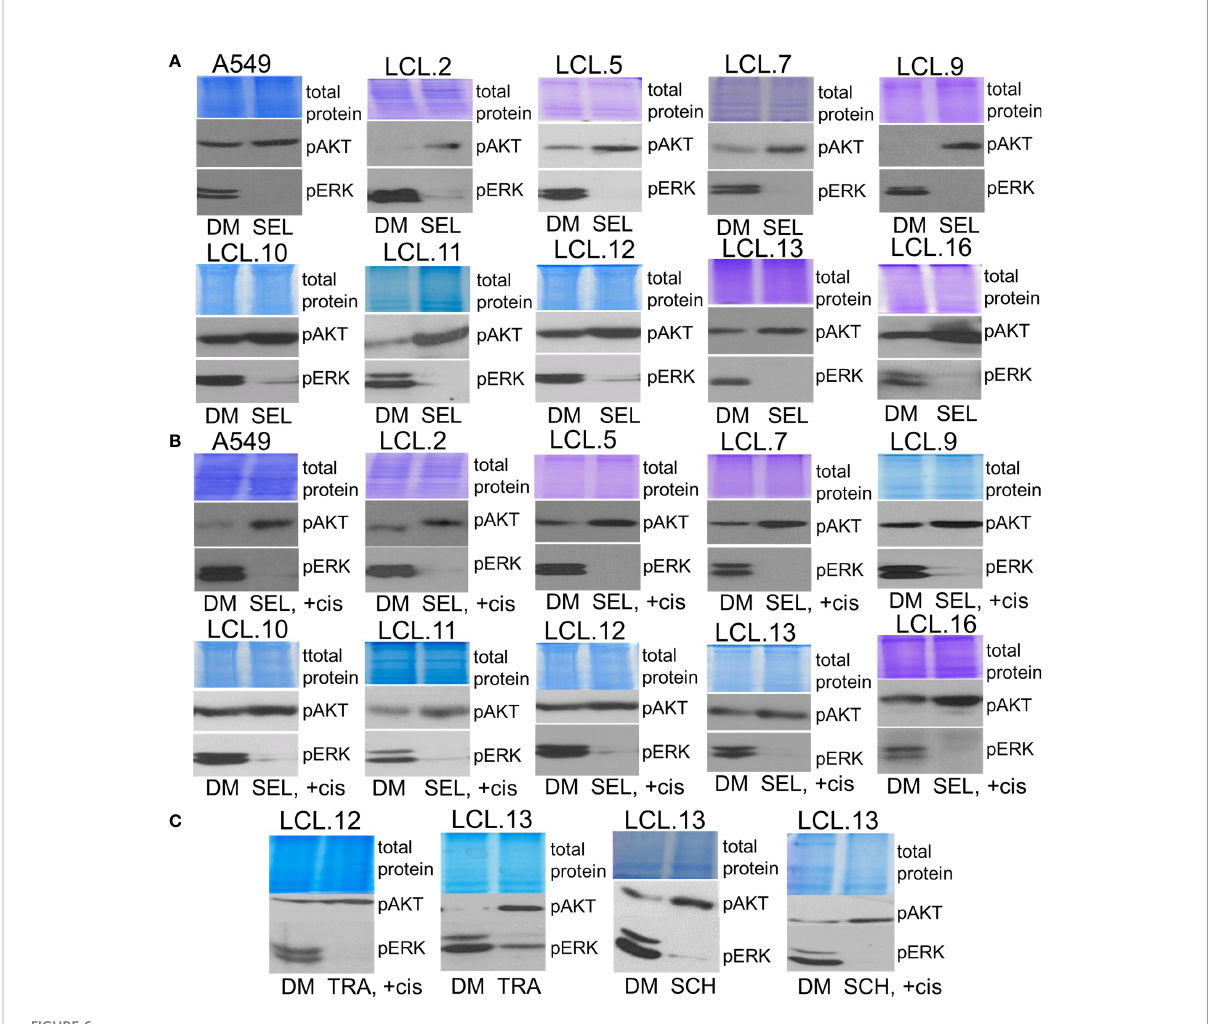
FIGURE 6 Crosstalk with negative feedback between ERK and AKT signaling pathways in human lung cancer-derived cell lines. (A, B) MEK/ERK pathway inhibitor selumetinib enhances AKT phosphorylation in the cell lines tested, control (A) and cisplatin-treated cells (B) . (C) MEK inhibitor trametinib as well as ERK inhibitor SCH772984 increase AKT phosphorylation in control and in cisplatin-treated cells. Representative Western blots are shown. Coomassie-stained protein gels are presented as loading controls. 6-hour-long exposures to the drugs were used. DM – vehicle control (DMSO), SEL – selumetinib (10 µM), +cis – cisplatin (90 µM), TRA – trametinib (1 µM), SCH - SCH772984 (1